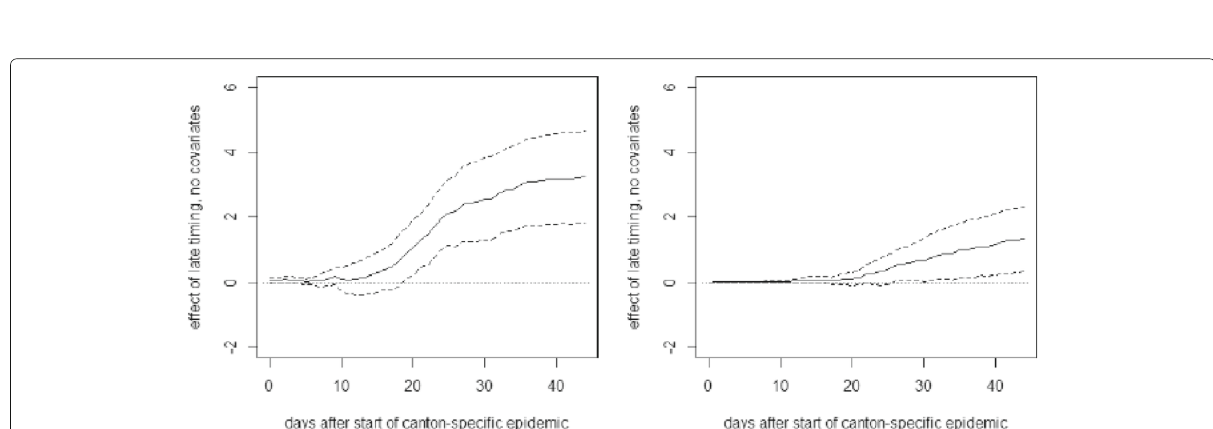
Fig. 13 OLS effect of late timing of measures on cumulative hospitalizations (left) and deaths (right) per 10,000 inhabitants without covariates excluding